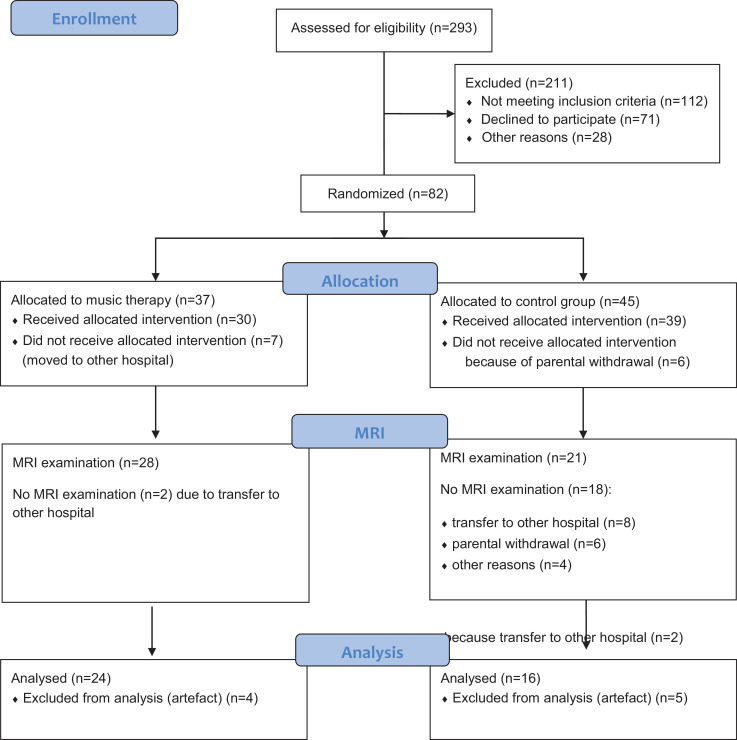
Flowchart. Overview of participant numbers of study enrollment, randomization, allocation, MRI exam and analyses.